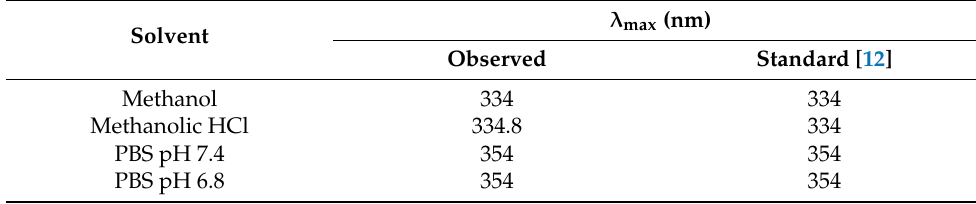
Table 3. λ max of PRX in different